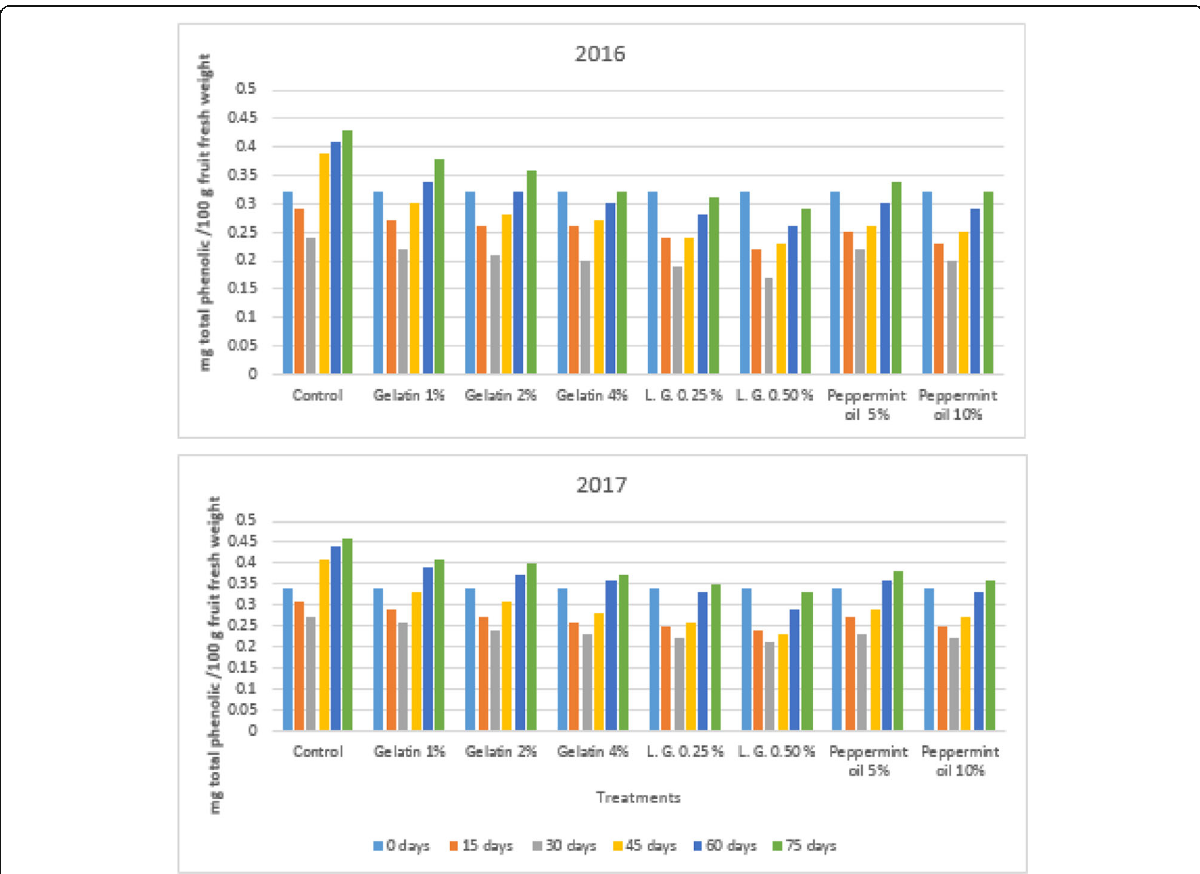
Fig. 2 Effect of gelatin, lemongrass oil and peppermint oil on fruit total phenolic content (mg total phenolic/100 g fruit fresh weight) of Samany date palm fruits stored at 0.0 °C ± 2 during two experimental